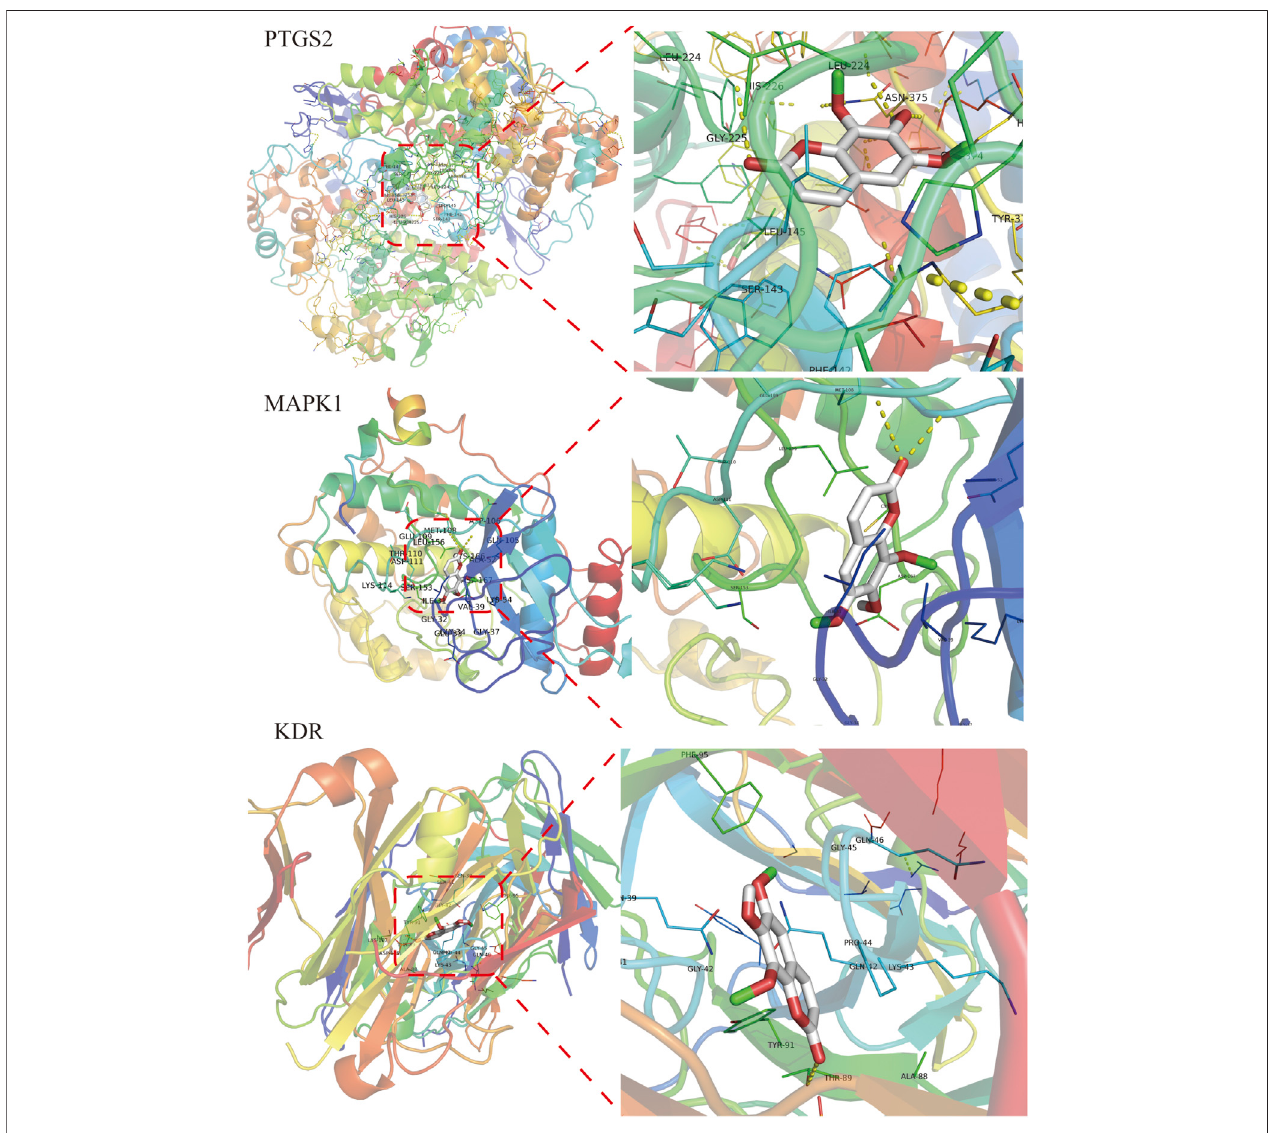
FIGURE 10 | Docking results of isofraxidin with key